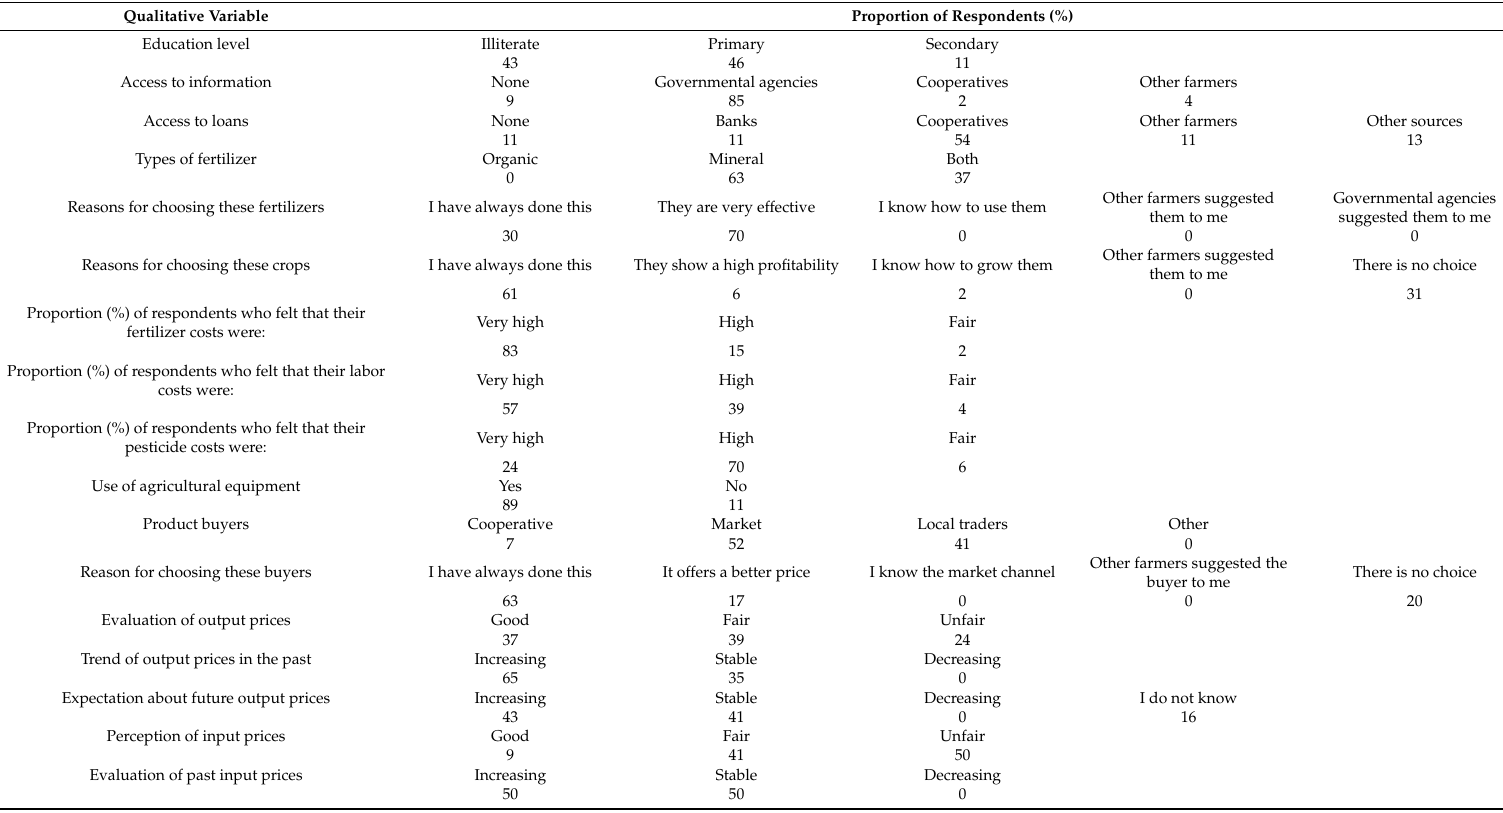
Table A2. Additional qualitative variables from the